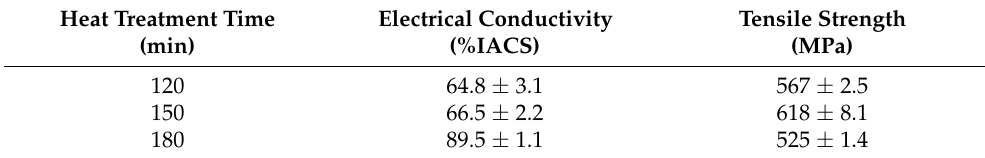
Figure 7. Stress–strain curves of deformed (TiB 2p +TiB w )/Cu composites with different heat treatment time. Table 2. Properties of (TiB 2p +TiB w )/Cu composites with different heat treatment time at 900 °C.